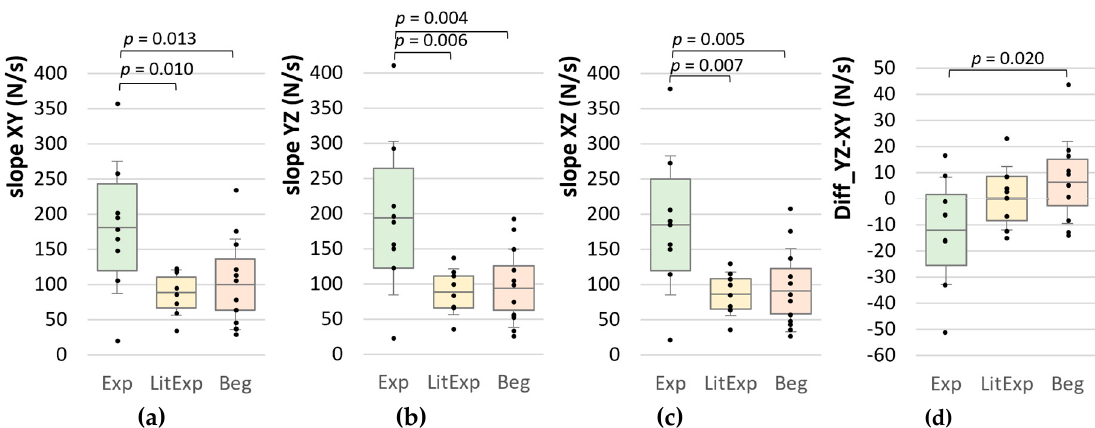
Figure 11. Slope parameters in the linear section XYZ. Displayed are the Ms, SDs (error bars) and 95%-CIs of the slope in the linear part of ( a ) between XY, ( b ) between YZ, ( c ) between XZ and ( d ) the difference between YZ and XY comparing the groups Exp (green), LitExp (yellow) and Beg (orange). The significant pairwise comparisons are marked with p -values (not adjusted).